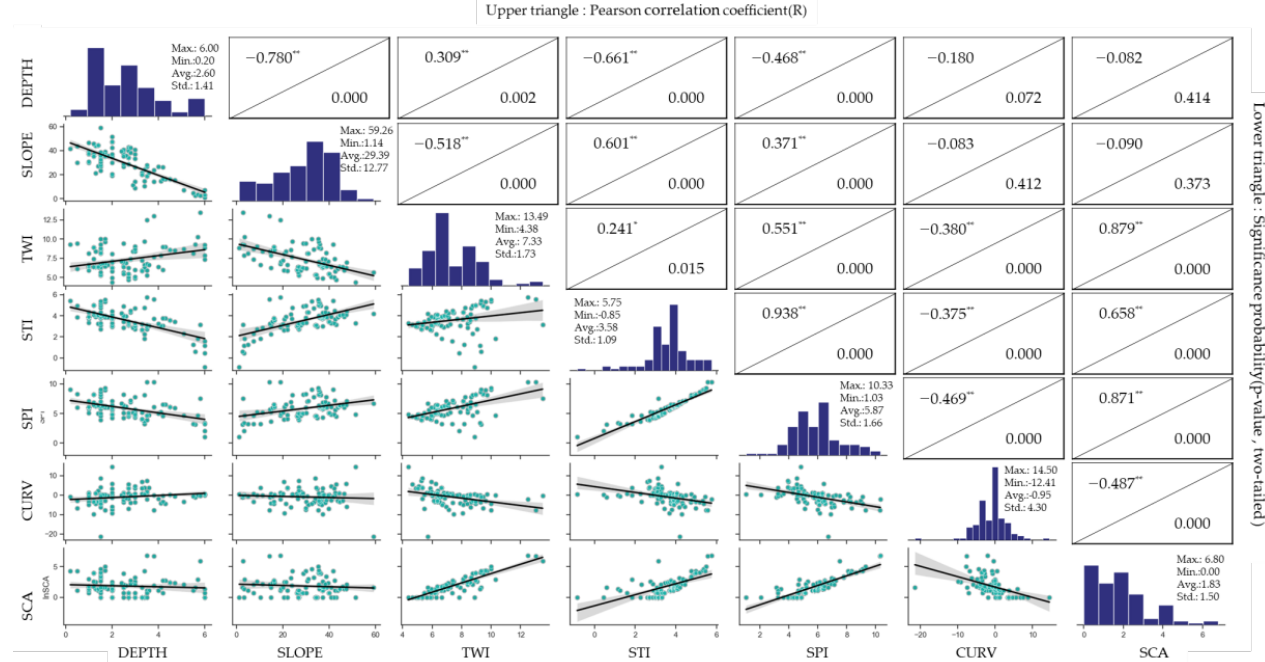
Figure 3. Correlation matrix for igneous rock (* Significant at the 0.05 probability level. ** Significant at the 0.01 probability level).